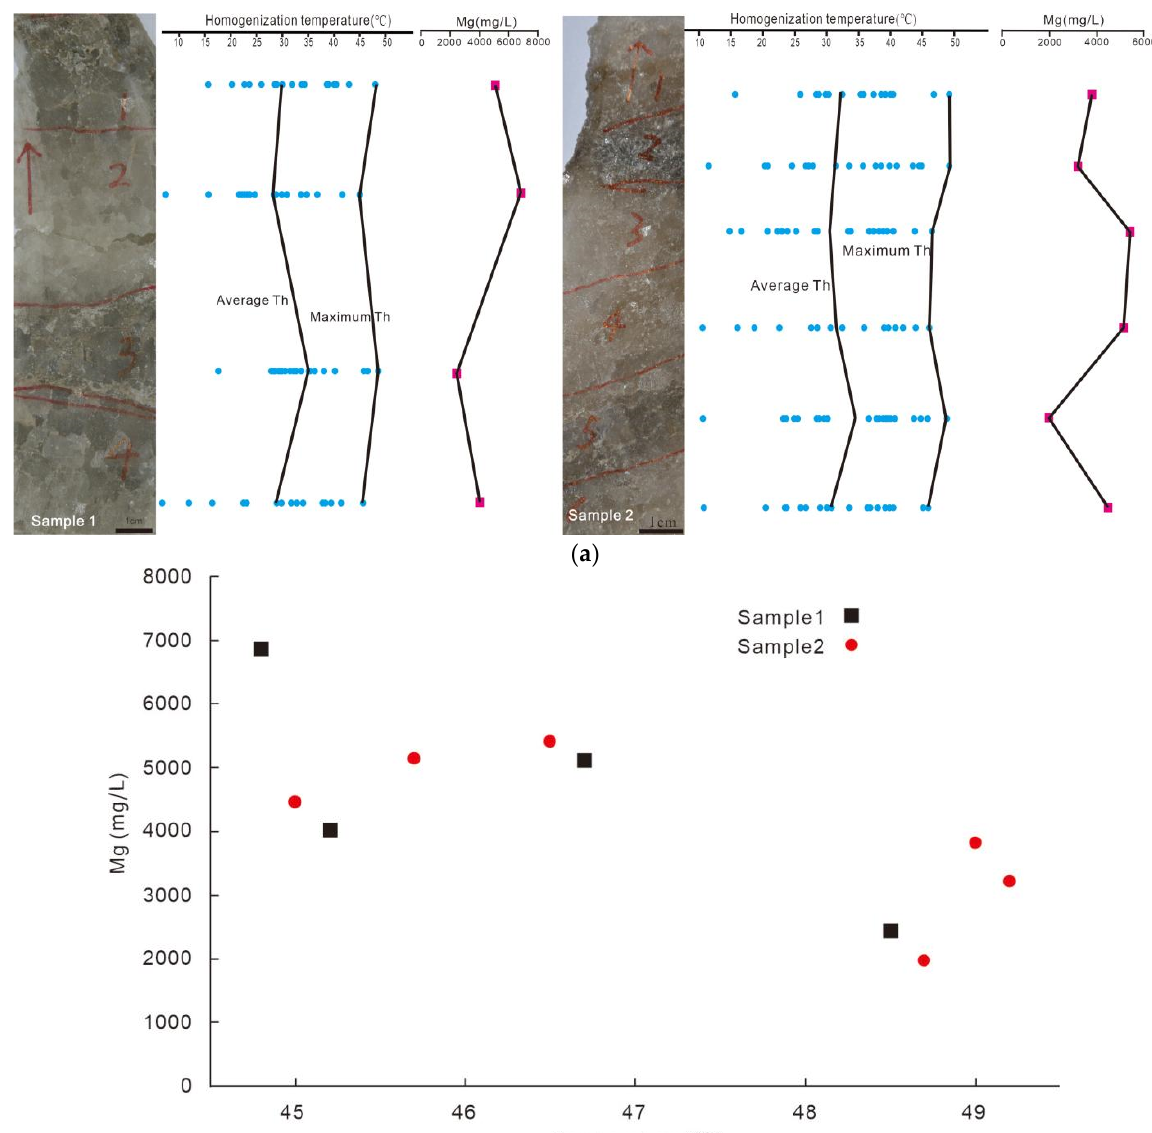
Figure 8. ( a ) Homogenization temperature curves of fluid inclusions in halite. ( b ) A positive correlation between homogenization temperature (Th) and Mg 2+ content.